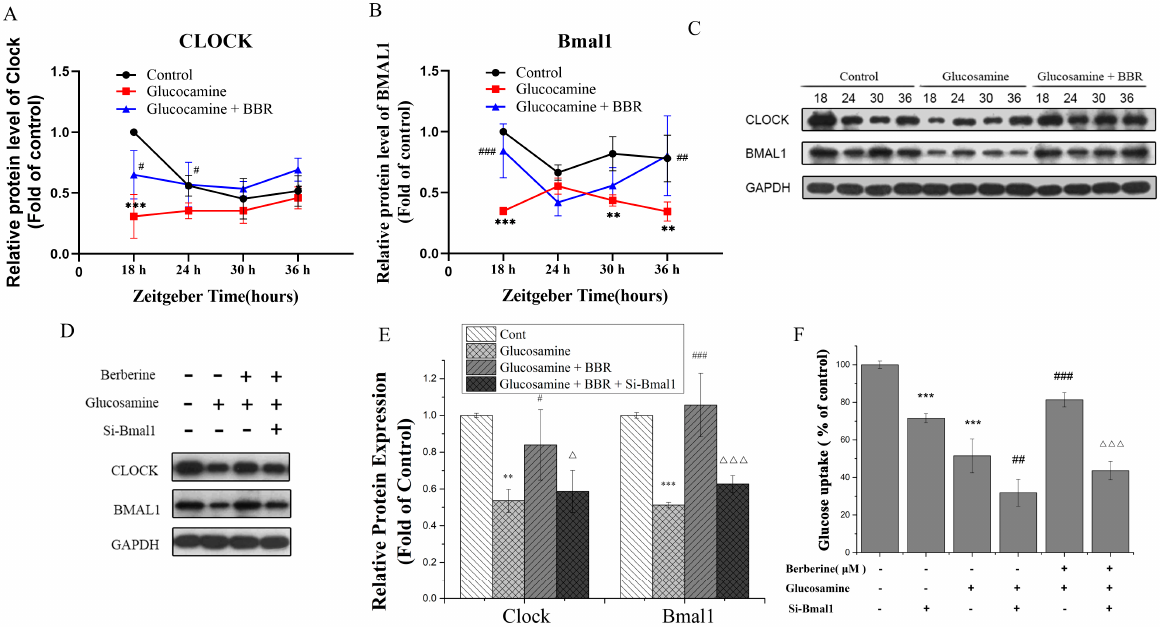
Figure 5 . BBR enhanced the expressions of Clock and Bmal1 after glucosamine or Bmal1 siRNA treatment. ( A – C ) Relative expression of Clock and Bmal1 proteins, as well as WB images of Clock and Bmal1 after transfection and treatment with glucosamine and BBR in HepG2 cells based on different time. ( D – F ) Relative expression of Clock and Bmal1 proteins, as well as WB images of Clock and Bmal1 after treated with si-Bmal1, BBR (5 µ M), and glucosamine for 48 h. All data are presented as the mean ± SEM ( n = 3). ** p < 0.01, and *** p < 0.001 compared to the control group; # p < 0.05, ## p <